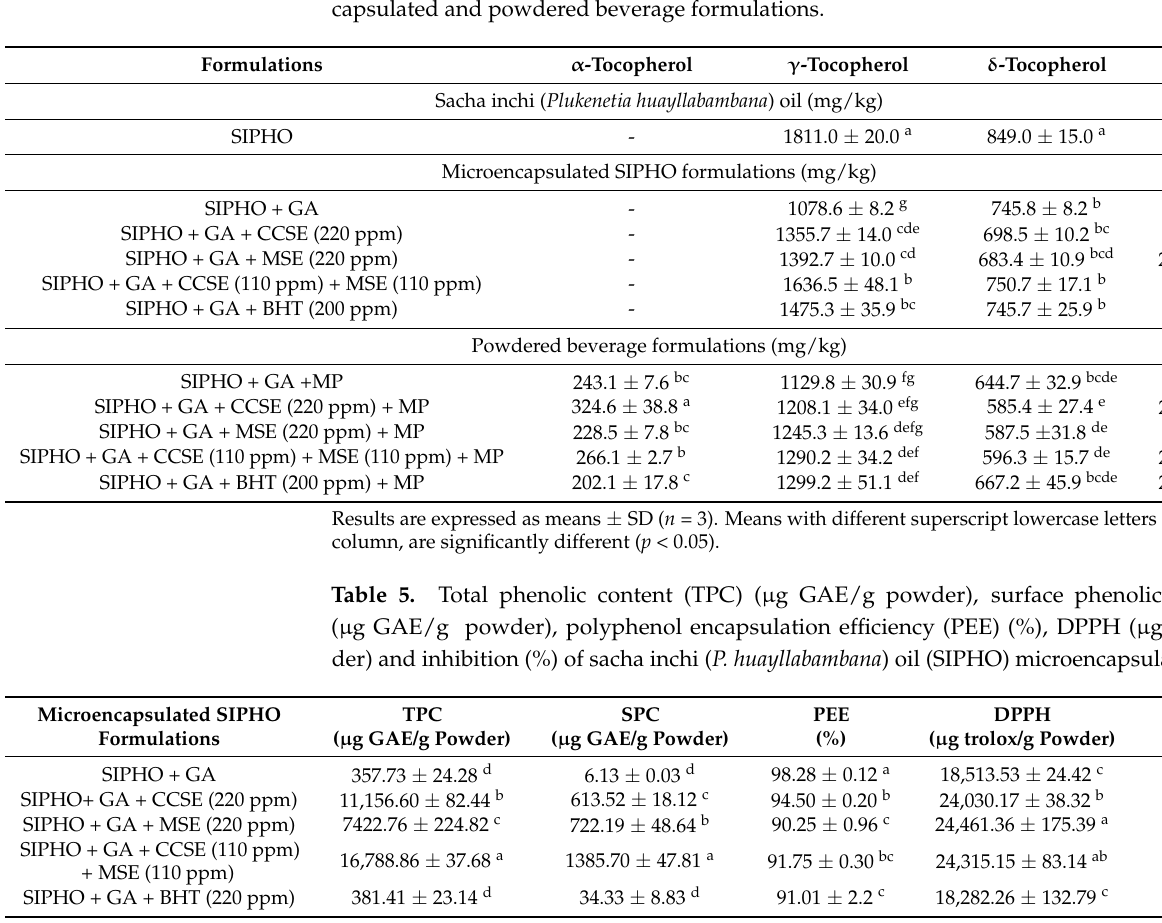
Table 4. Composition in tocopherols (mg/kg) of sacha inchi ( P. huayllabambana ) oil (SIPHO) microen- capsulated and powdered beverage formulations.